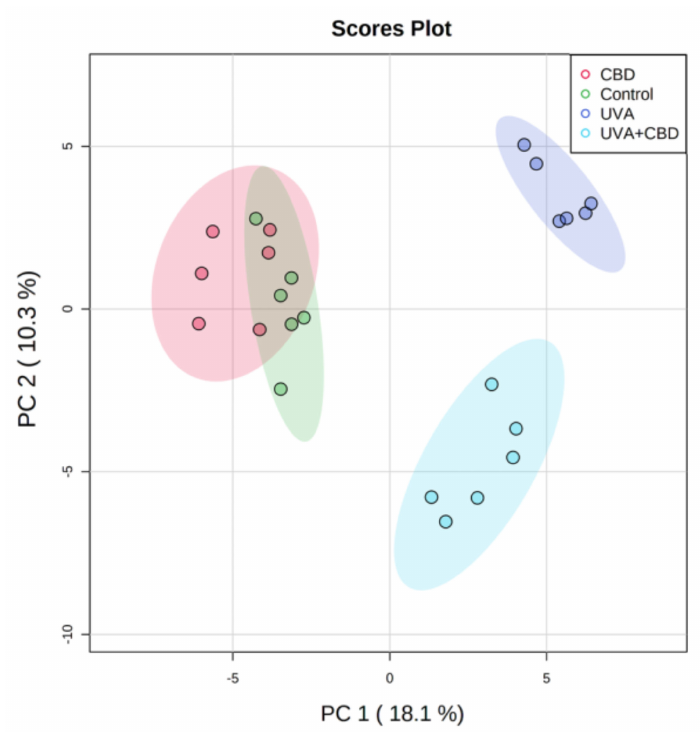
Figure 1. Two-dimensional principal component analysis (2D PCA) scores plots of the relative abundance of phospholipid species related to the internal standard of each phospholipid class in keratinocytes isolated from the skin of control (Control) and rats with UVA-irradiated rats (increasing doses of 0.5 to 5 J / cm 2 for 4 weeks). These cells have not been treated (Control and UVA) or treated with cannabidiol (CBD) (CBD and UVA + CBD) (2.5 g CBD in 100 g